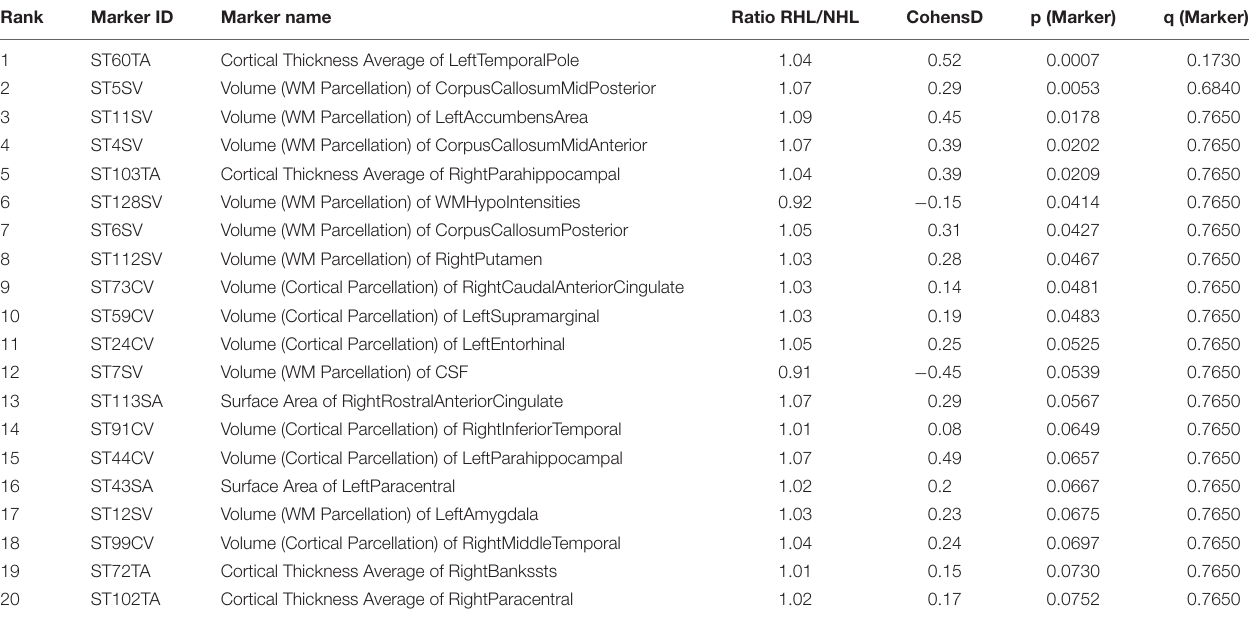
TABLE 2 | Top 20 markers, based on p and q -values, differentiating RHL from NHL in cognitively normal subjects, corrected for age and